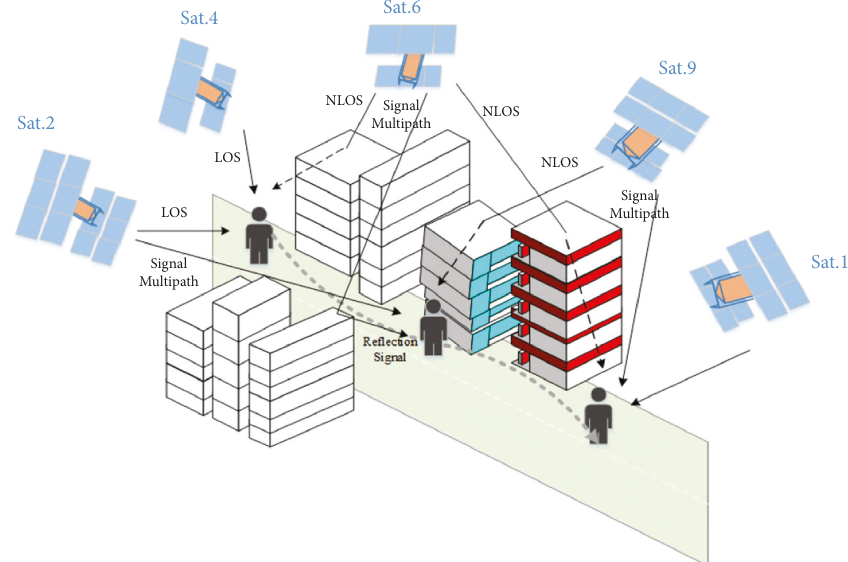
Figure 1: The multipath phenomena in the urban